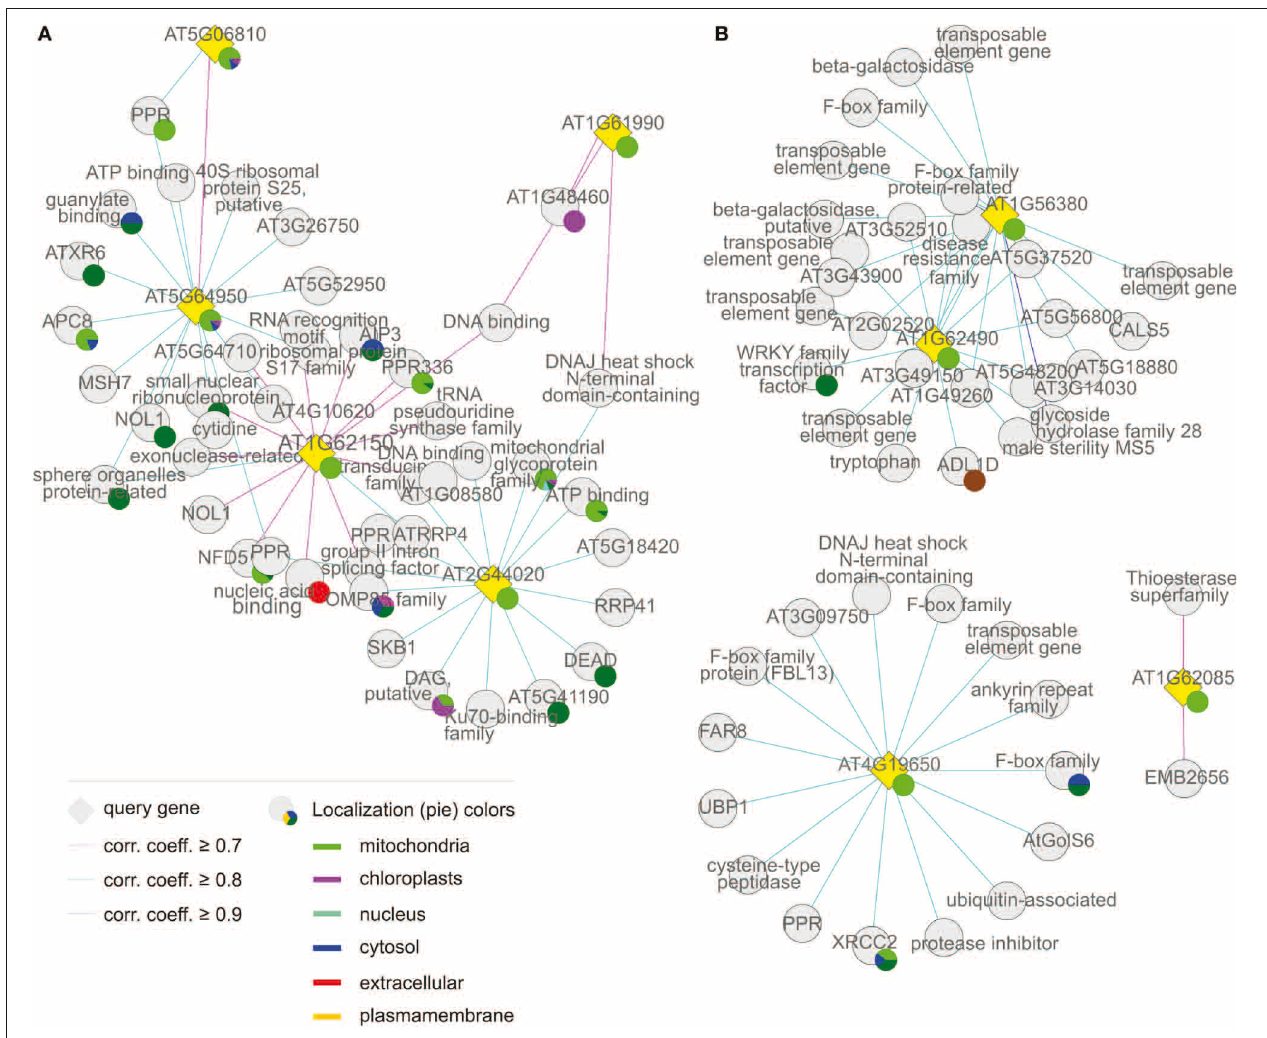
FIGURE 7 | Coregulation network of (A) group (iv), the “mitochondrion associated” cluster and (B) group (v), “the others.” The coregulation network was generated as in Figure 4